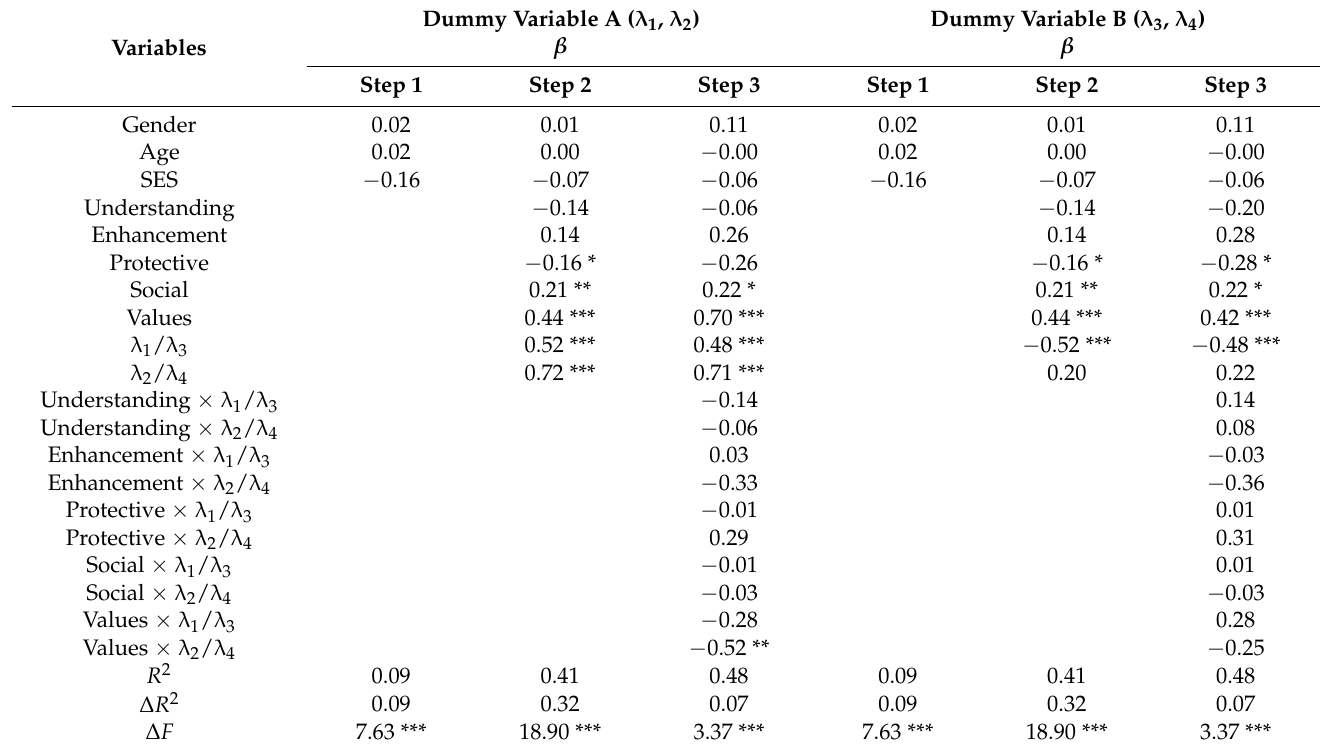
Table 2. Results of hierarchical regression analyses on future intention of blood donation 2 .